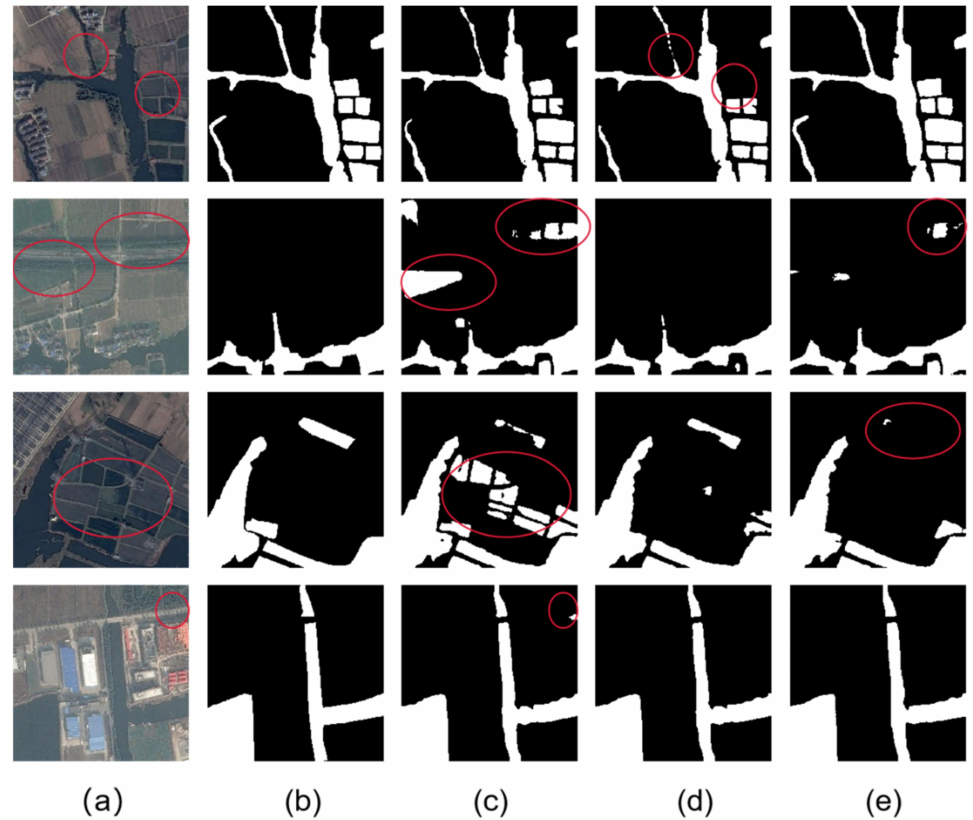
Figure 10. The results of water-body detection. ( a ) Raw image, ( b ) ground truth, ( c ) results of our MSResNet via rotation transformation learning and ( d ) results of our MSResNet via flip transforma- tion learning, ( e ) results of our MSResNet via rotation transformation learning, flip transformation learning, noise disturbance learning and image resolution